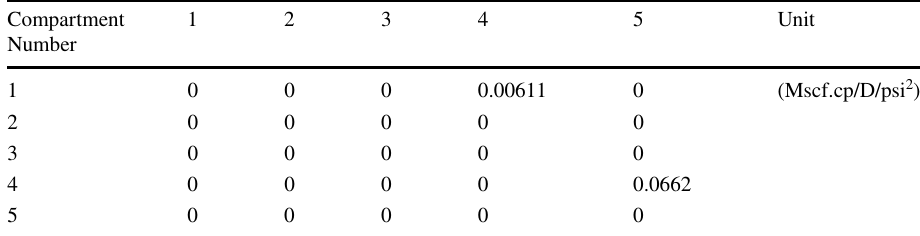
parameters for layer 2 in field case